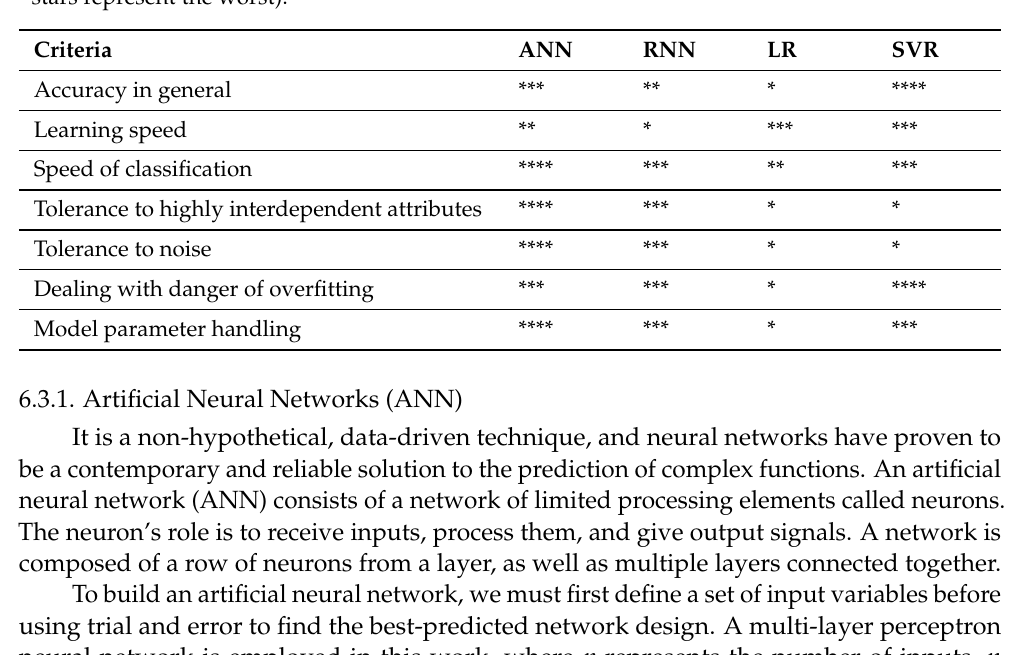
Table 4. Comparing machine learning algorithms (**** stars represent the best performance and * stars represent the